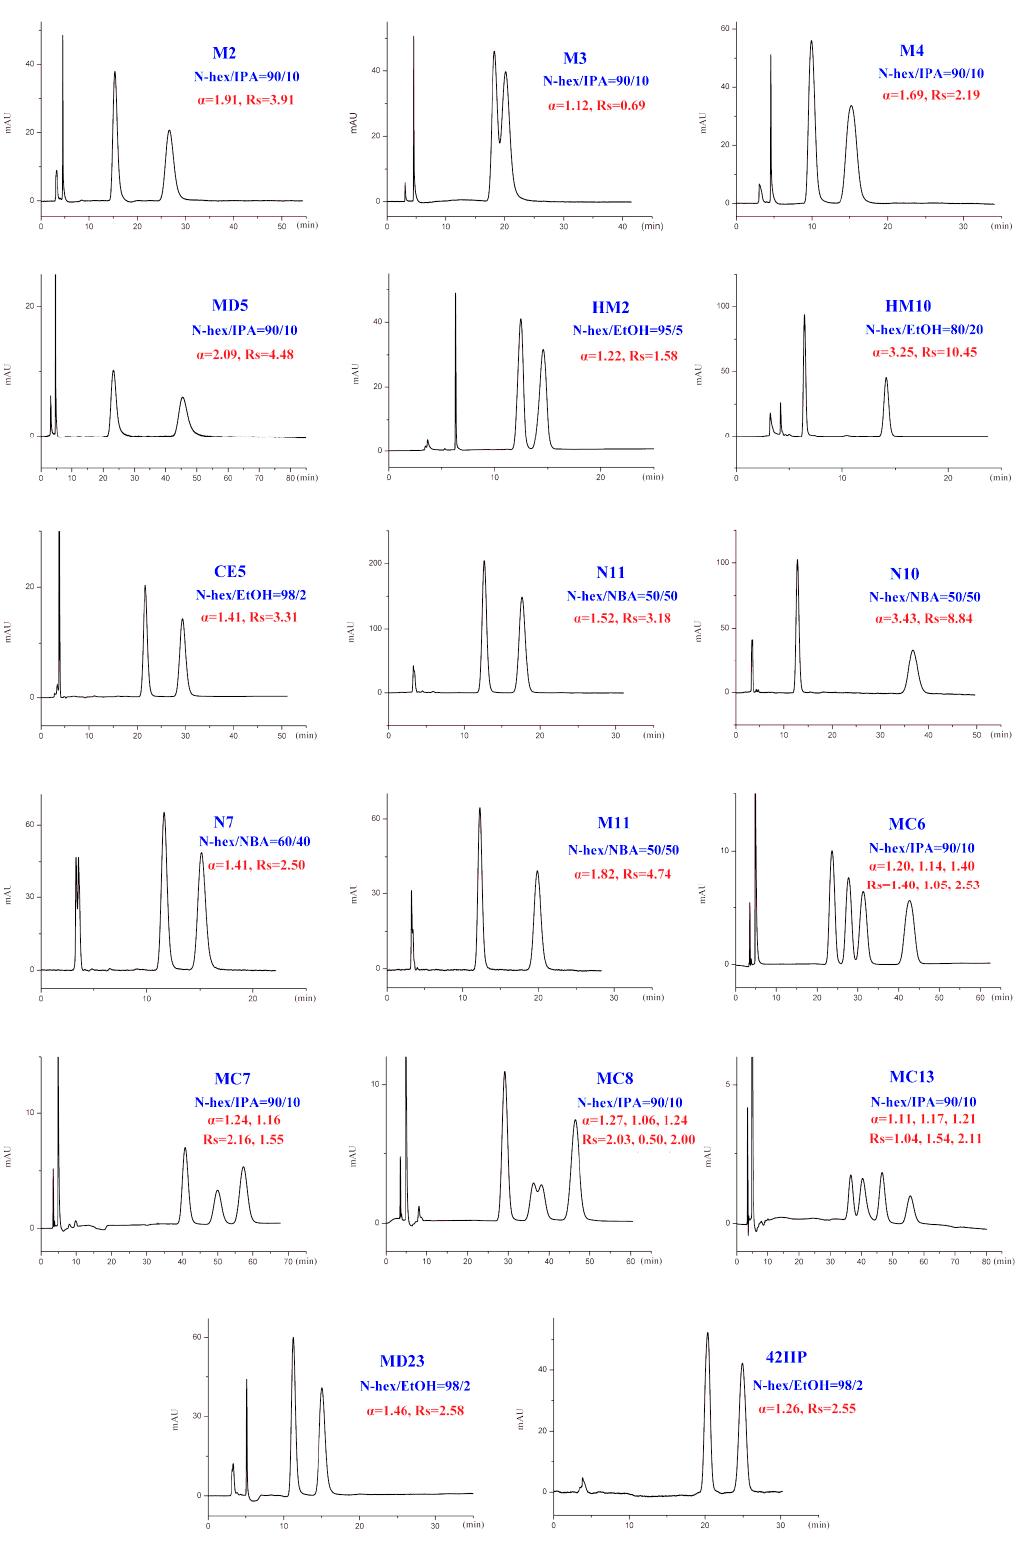
Figure 7. The chromatograms of 17 analytes under optimized conditions of normal-phase